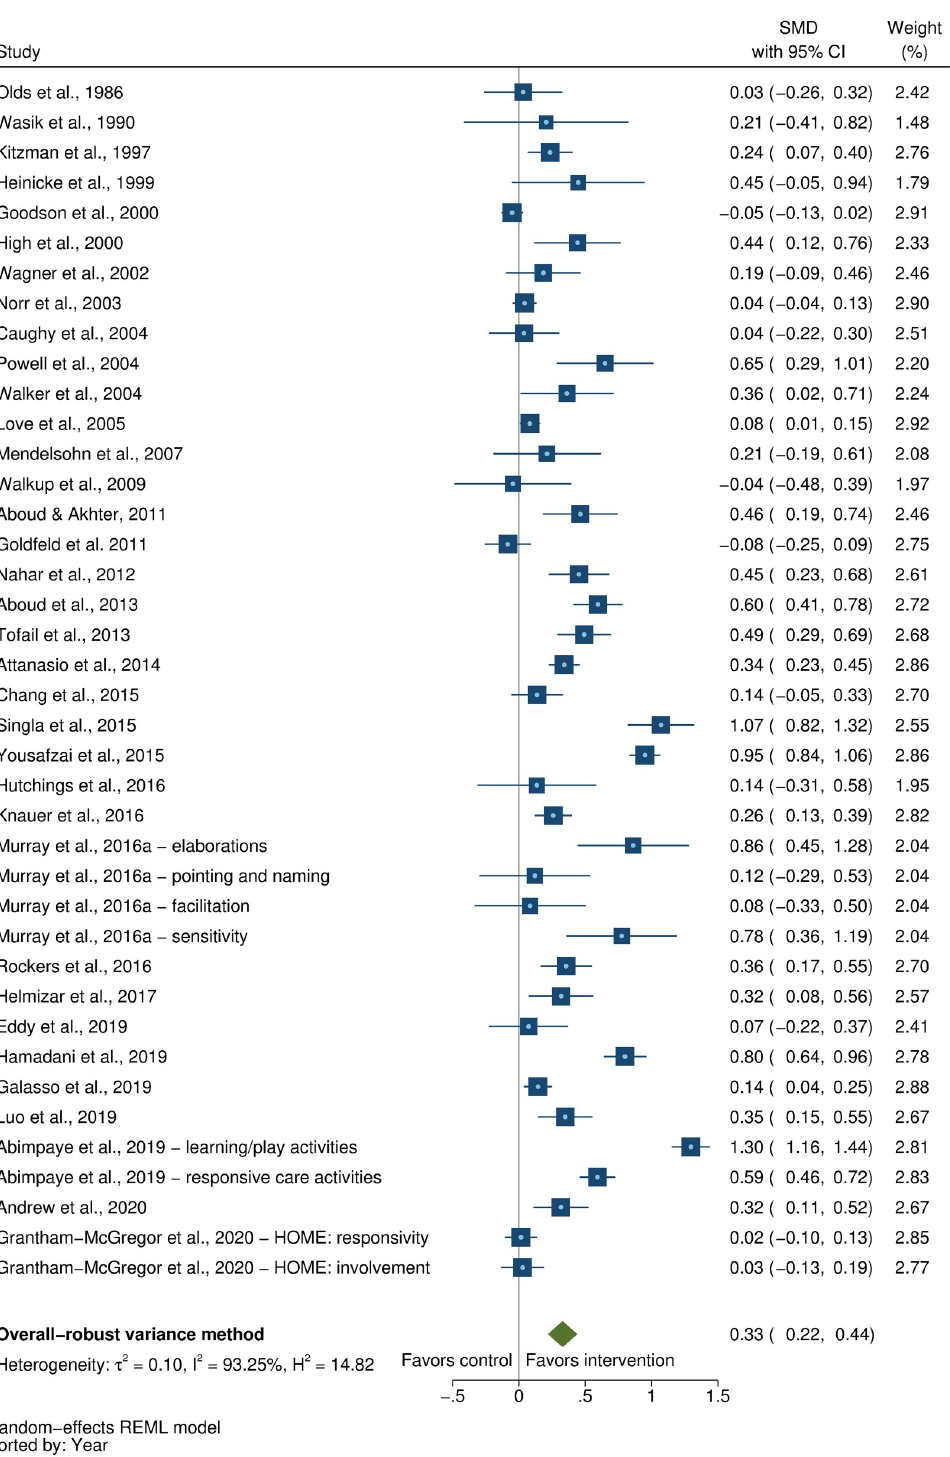
Fig 9. Forest plot for the effect of parenting interventions on parenting practices. Blue squares represent the SMD for each study, with the size of the square being proportional to the study weight. The whiskers extending from each side of the square represent the range of the 95% CI. The green diamond shows the overall pooled effect size using a random- effects model, which is centered at the point estimate and the diamond width representing the 95% CI. SMD, standardized mean